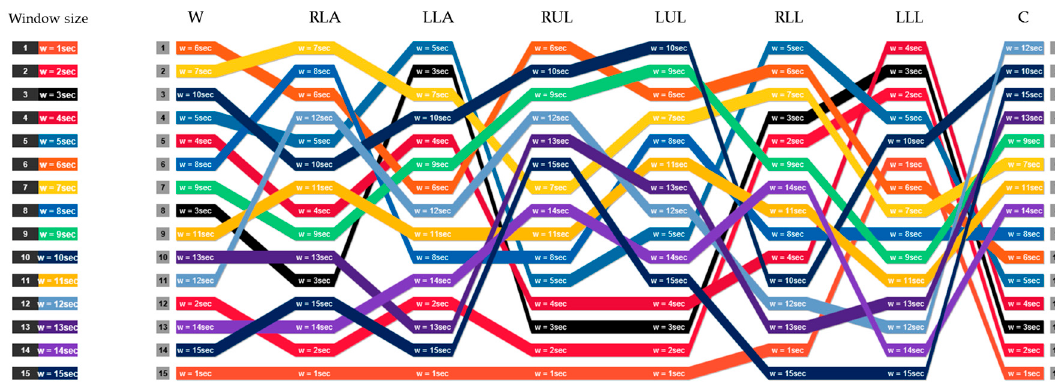
Figure 6. The rank of window sizes in providing the best accuracy in each position.